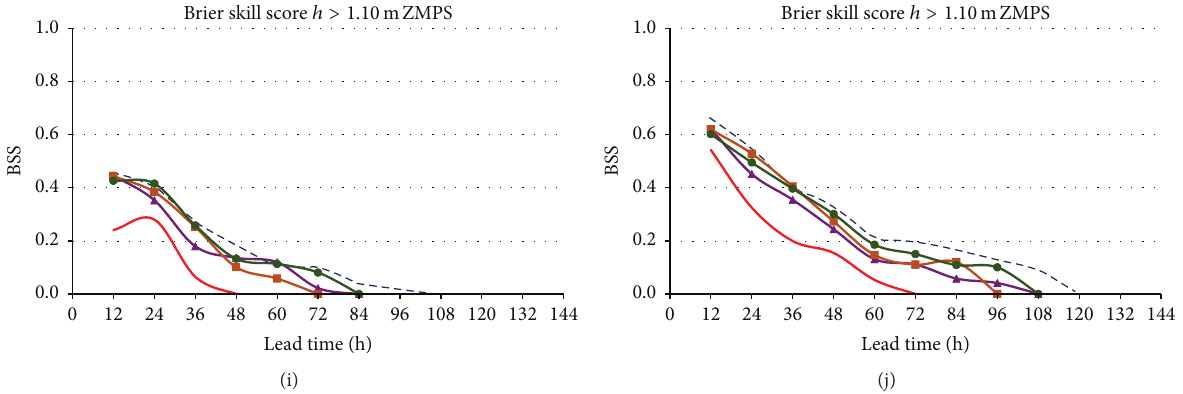
Figure 3: Brier skill score as function of lead time for the four different dressing methods (red thick line: UDPF, violet continuous cum dotted line: EDPF, brown continuous cum dotted line: MDPF, and green continuous cum dotted line: MULTIPDF) is compared to the EPS BSS (blue dash line). In (a, c, e, g, i)/(b, d, f, h, j), the BSS is computed with respect to observations/hindcast, considering SR = 0, 25, and 50 cm and SL = 80 and 110cm.